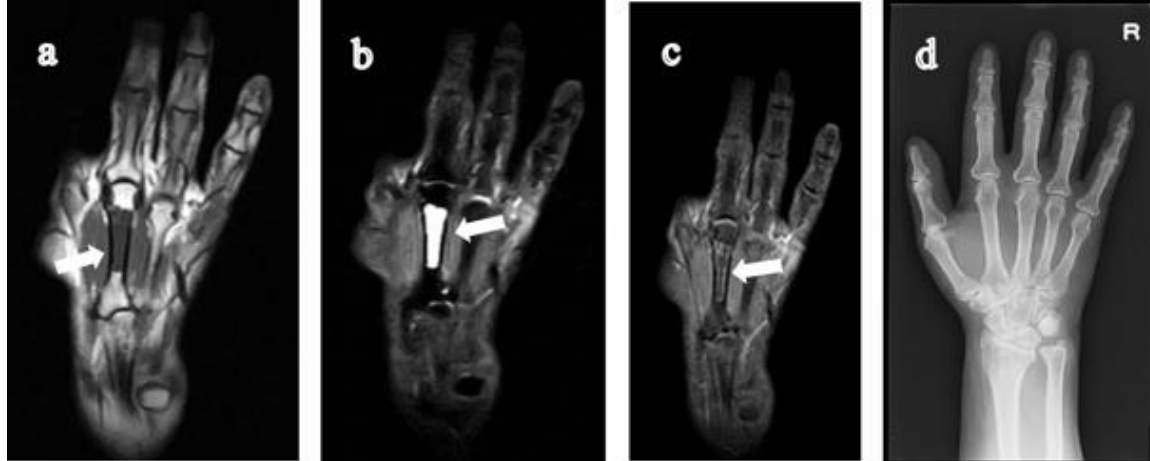
Figure 4. 62-year-old woman with rheumatoid arthritis for one year. ( a ) T1-weighted coronal image of the 3rd metacarpal bone of the right hand shows a low signal lesion (solid arrow) that originated from the distal and extended to the central diaphysis of the metacarpal bone. On STIR coronal image ( b ), the lesion has a high signal intensity (solid arrow) with clear boundaries. ( c ) Contrast-enhanced fat-suppressed T1-weighted coronal image shows an enhancement of peripheral margins. On CR ( d ), the bone lesion is not visible. RA, rheumatoid arthritis; STIR, short tau inversion recovery; CR, computed radiography.